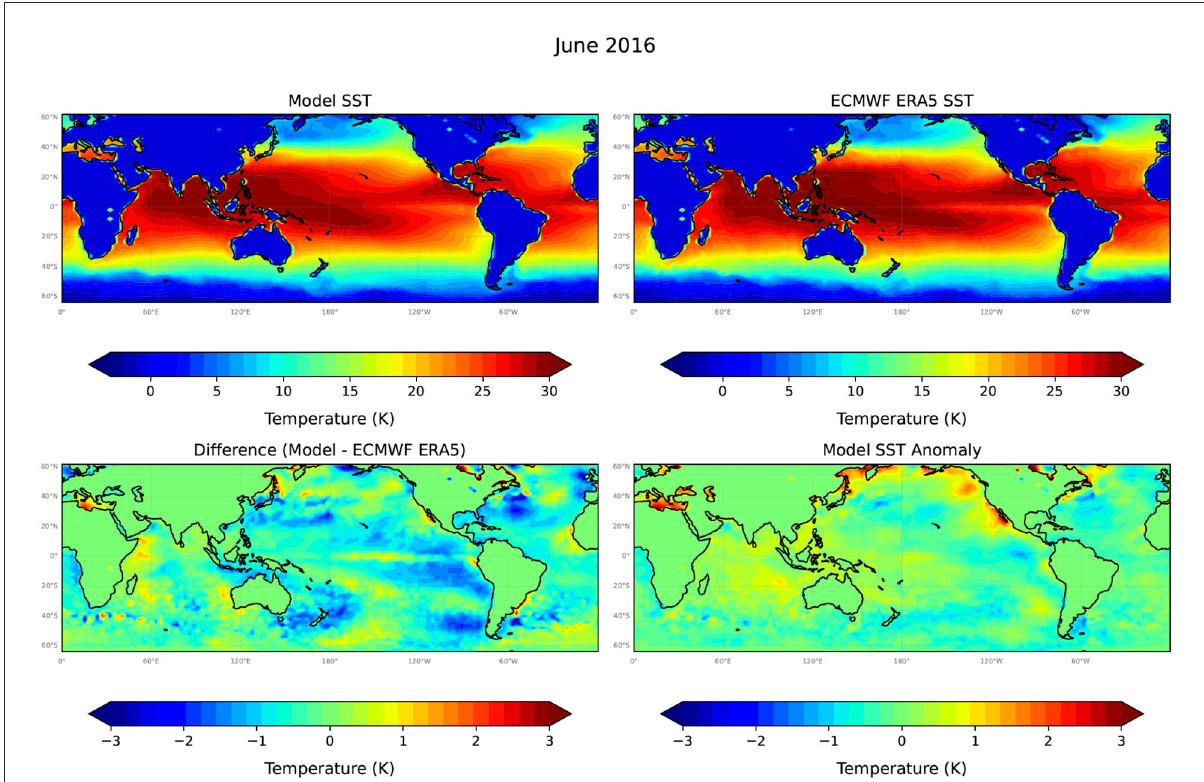
FIGURE5 The model predicted SST at +6 months (June 2016), from a model forecast initiated in December 2015, the corresponding target ERA5 SST data set, the difference between the model predictions and the target, and the model predicted SST anomaly. Note the different, much higher resolution temperature scale used to plot model differences and SST